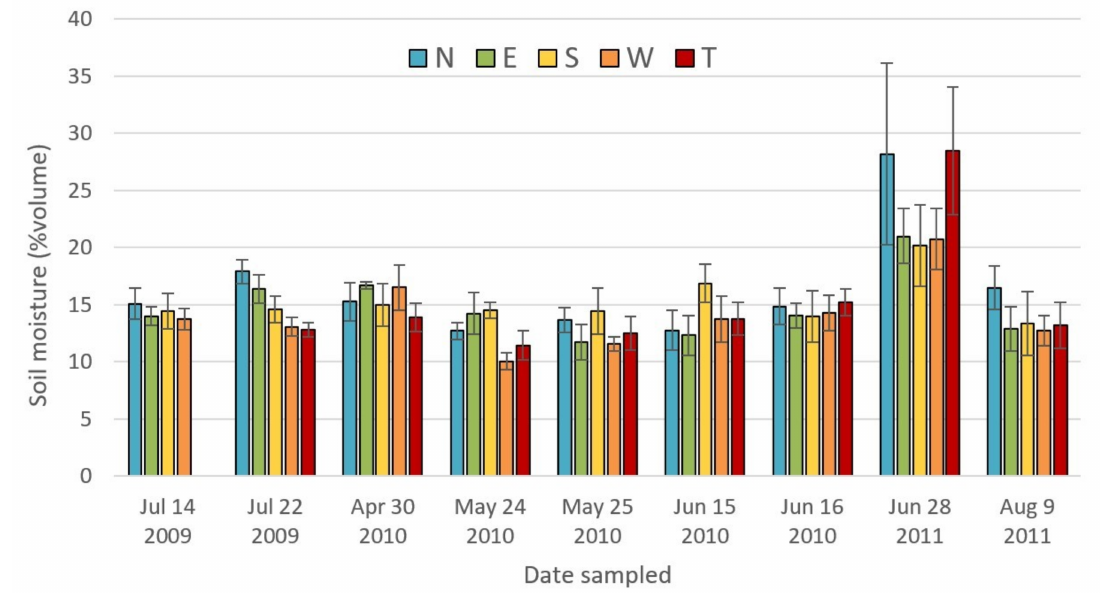
Figure 7. Mean volumetric soil moisture on each aspect and the tops (T) of mounds on each sampling